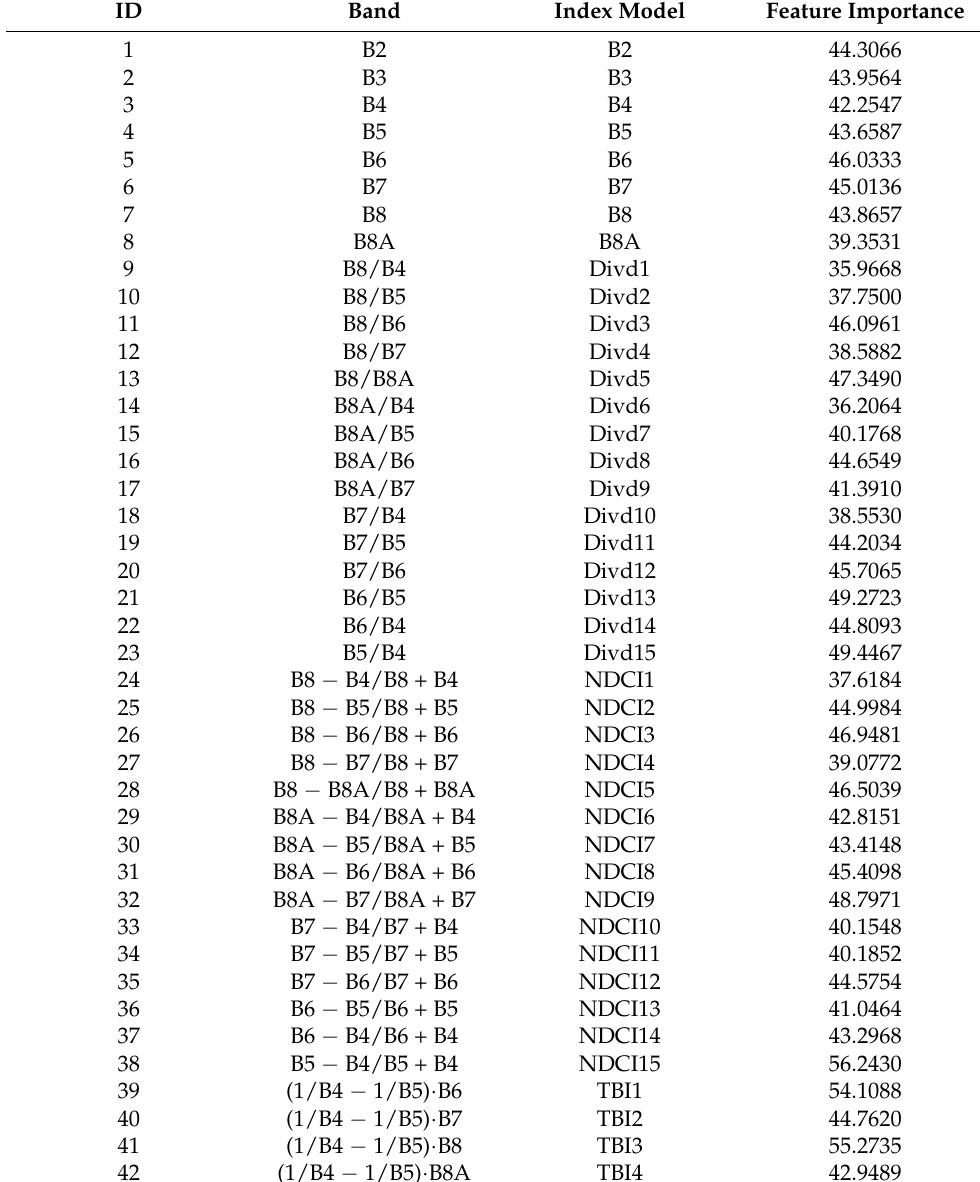
Table 4. Feature importance computational